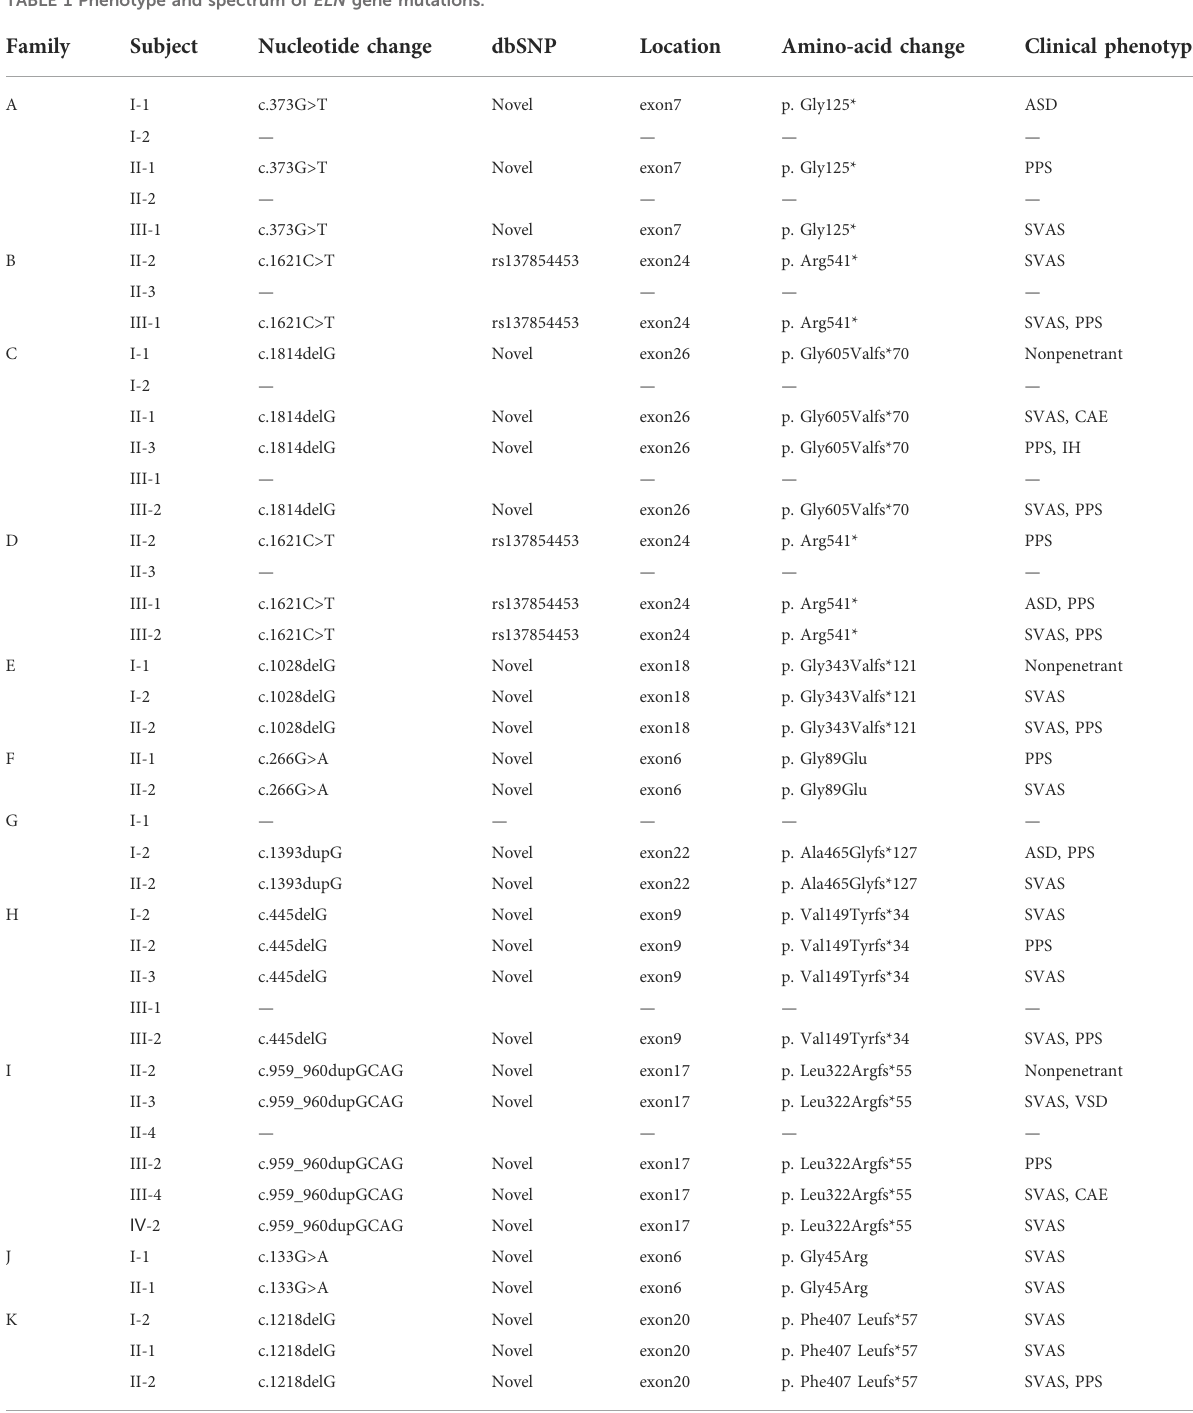
TABLE 1 Phenotype and spectrum of ELN gene mutations.